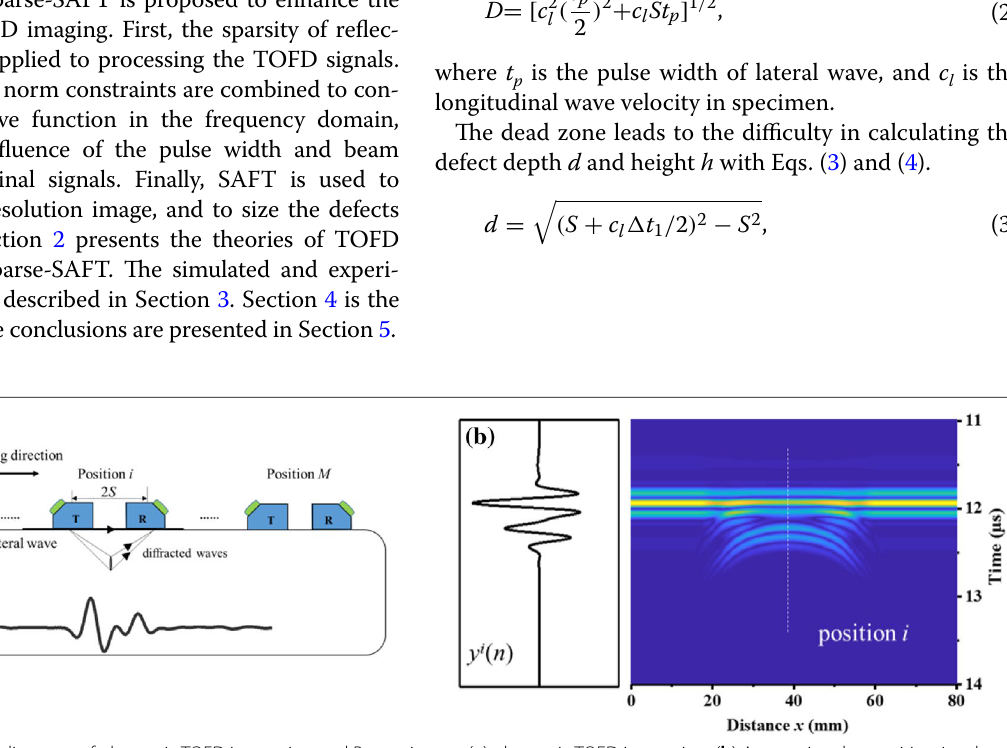
Figure 1 Schematic diagrams of ultrasonic TOFD inspection and B-scan image: ( a ) ultrasonic TOFD inspection, ( b ) A-scan signal at position i and B-scan